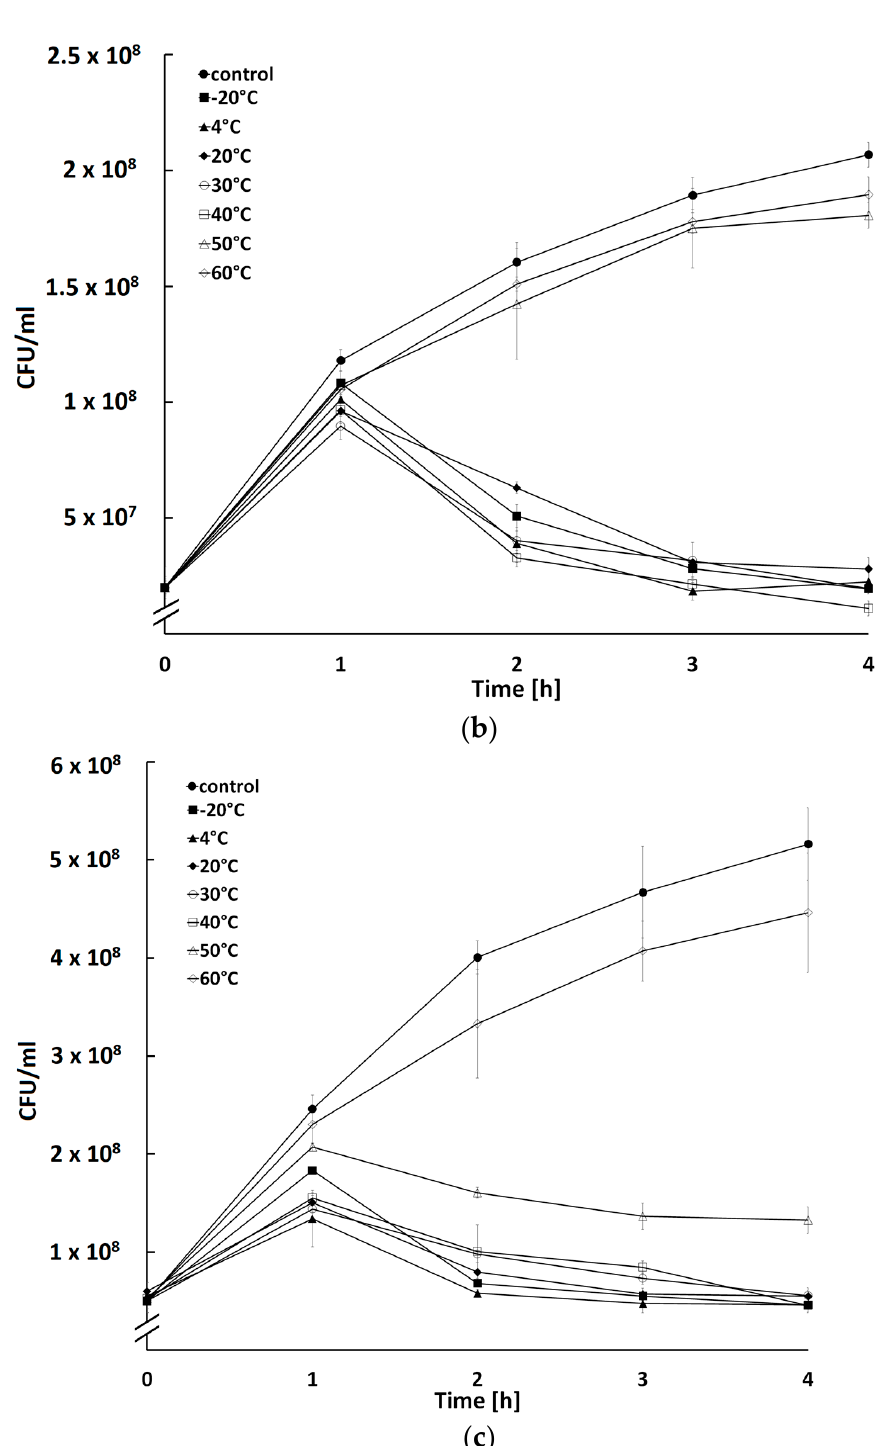
Figure 6. Bactericidal activity of phages BF9 ( a ), BF15 ( b ), and BF17 ( c ) pre-incubated at different temperatures on count of the host strain. Each data point represents the mean and standard deviation of three different experiments.